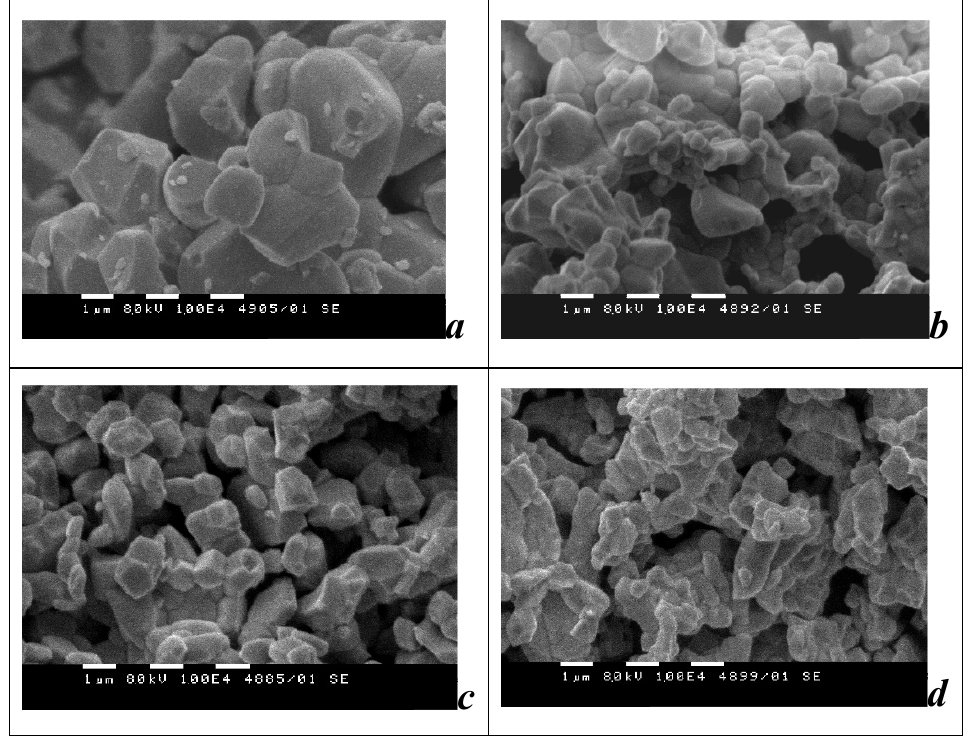
Figure 5. SEM photographs of ( a ) BiFeO 3 , ( b ) Bi 0.9 Nd 0.1 FeO 3 , ( c ) Bi 0.9 Gd 0.1 FeO 3 , and ( d ) Bi 0.9 Ho 0.1 FeO 3